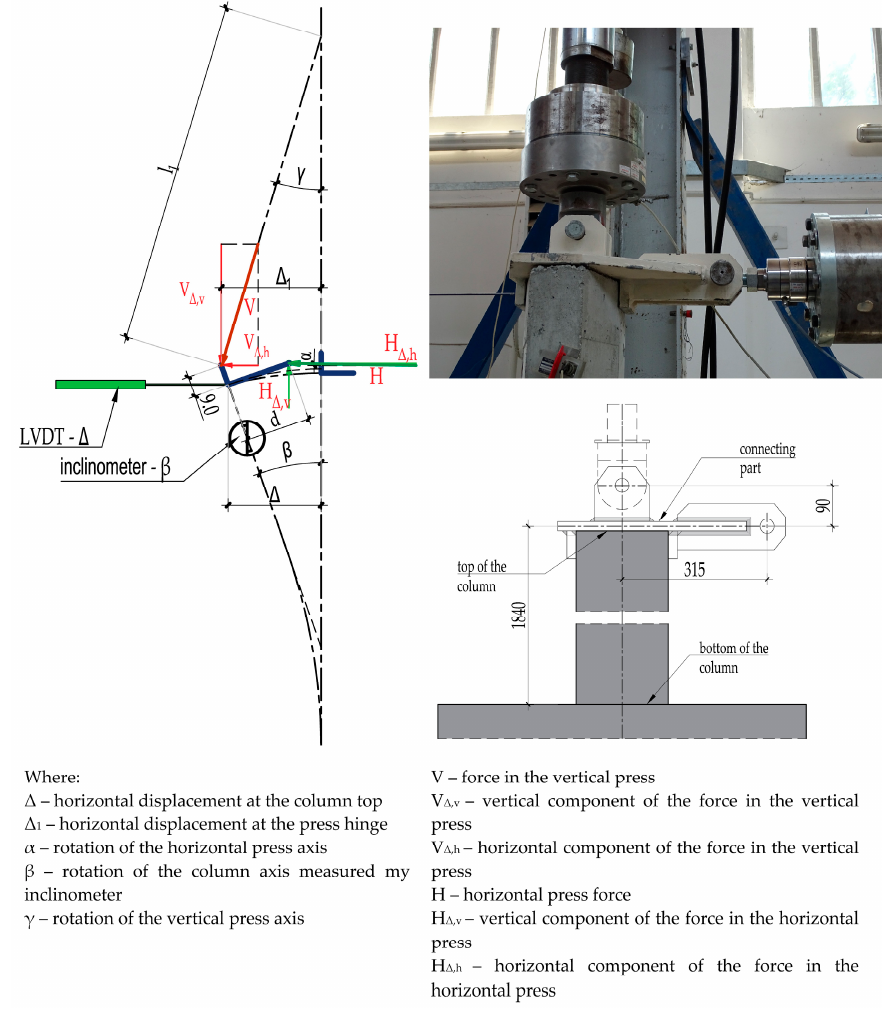
Figure 4. Effect of the vertical press rotation to a horizontal force component.